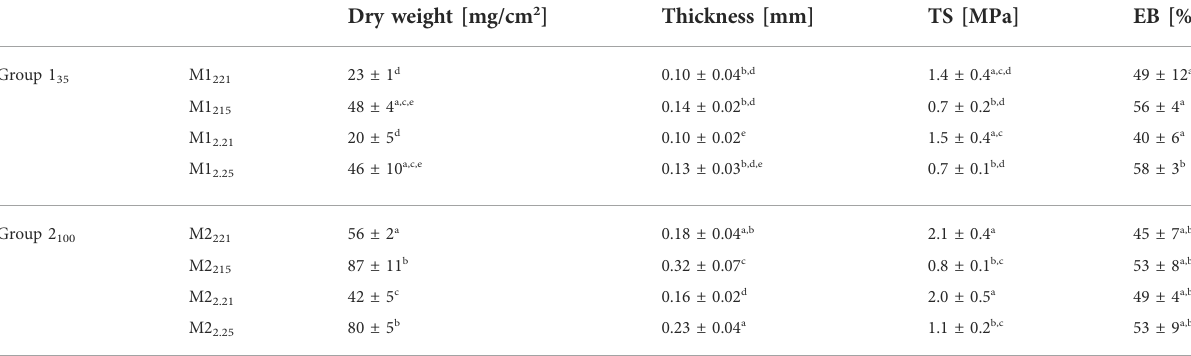
TABLE 3 Biomembranes: Physical and mechanical